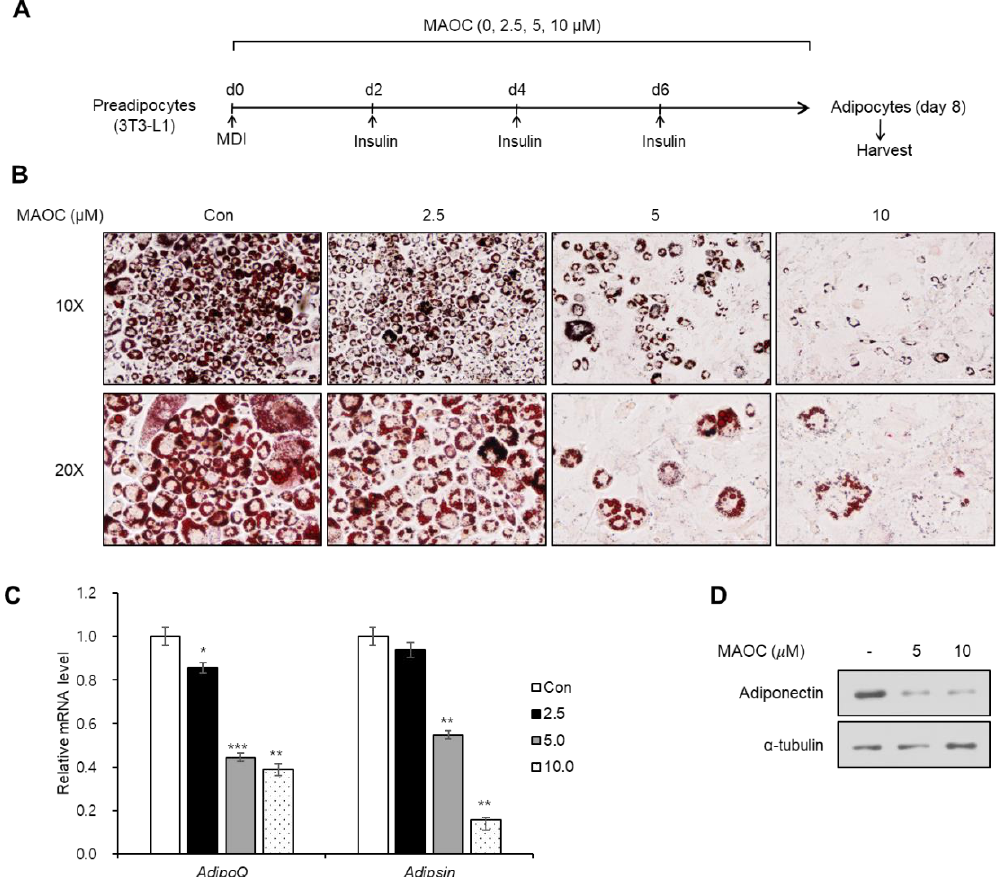
Figure 2. The inhibitory effects of morolic acid 3- O -caffeate (MAOC) on adipogenesis. ( A ) Schematic representation of 3T3-L1 differentiation into adipocytes. Cells were treated with MAOC during the entire period of differentiation. ( B ) Oil Red O staining of 3T3-L1 adipocytes incubated with MAOC during adipogenesis. ( C ) The mRNA levels of Adipoq and Adipsin genes in 3T3-L1 adipocytes incubated with MAOC during adipogenesis. Data present the means ± standard error of the mean (SEM) for n = 3. * p < 0.05, ** p < 0.01, and *** p < 0.001. ( D ) Western blot analysis of 3T3-L1 adipocytes incubated with MAOC during adipogenesis.